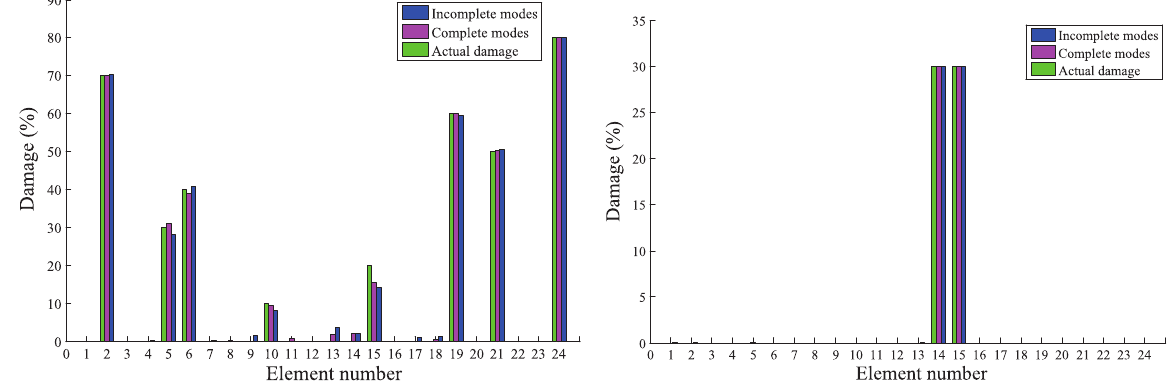
Fig. 12. Damage detection via BB-BC for three damage locations of frame (Scenario 2).